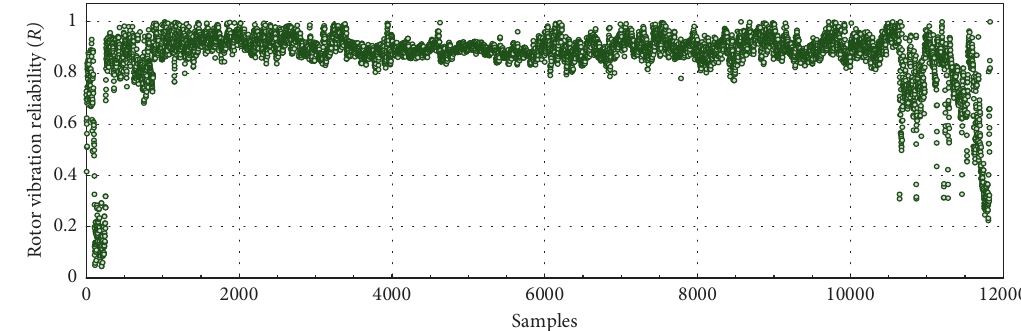
Figure 3: The value of R during operation.